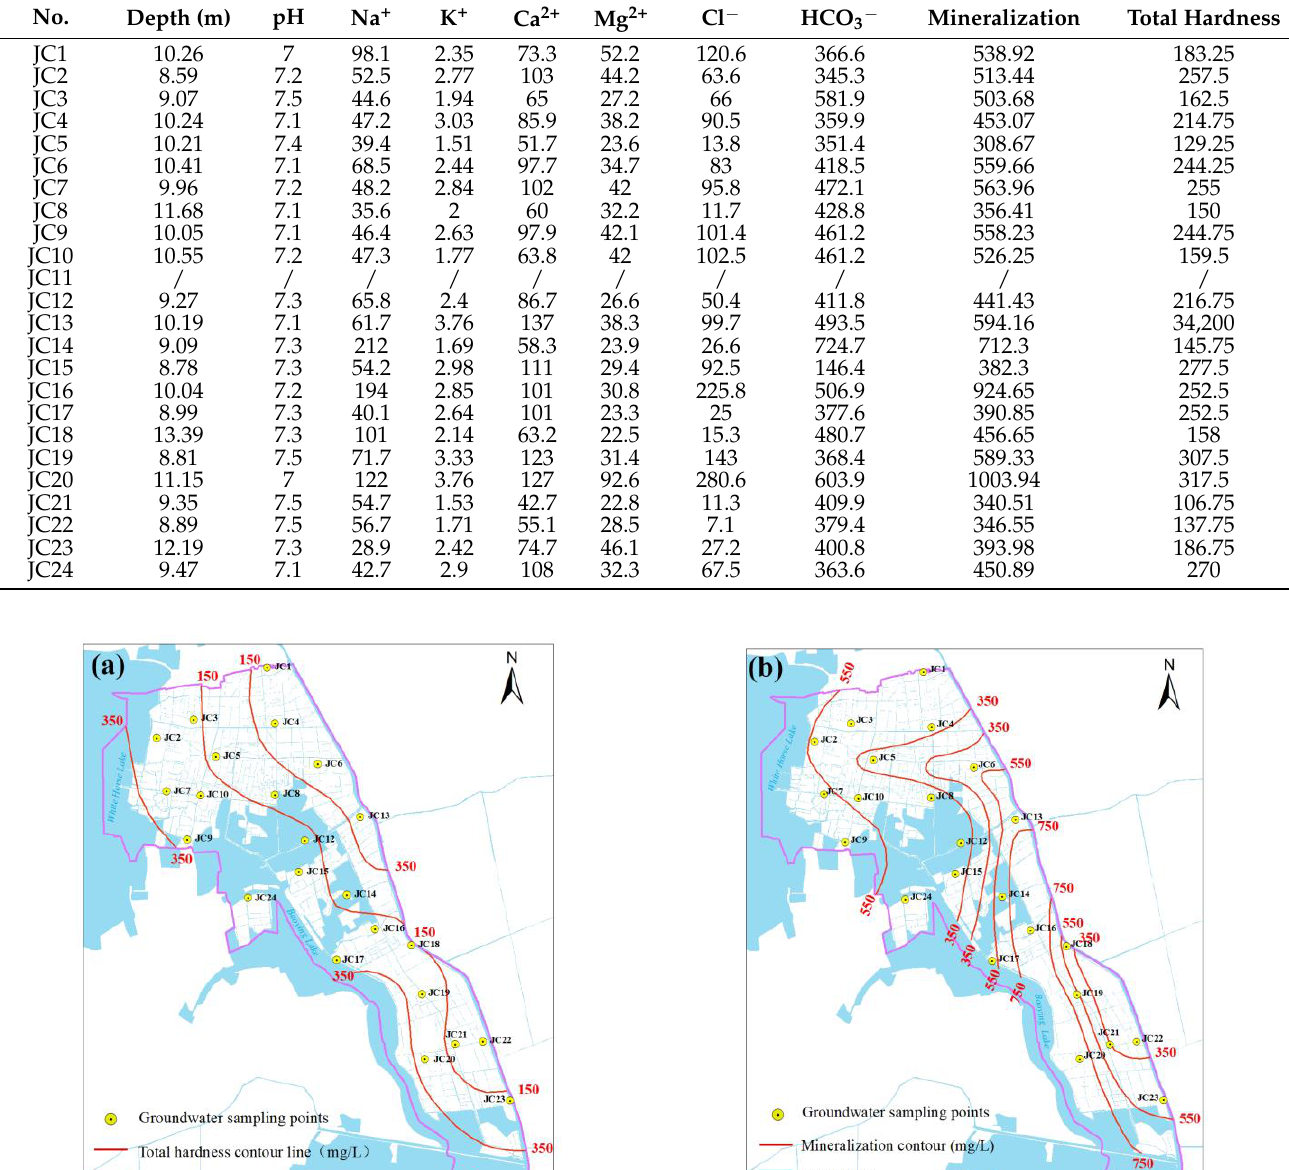
Table 3. Groundwater quality analysis results (Unit: mg/L).